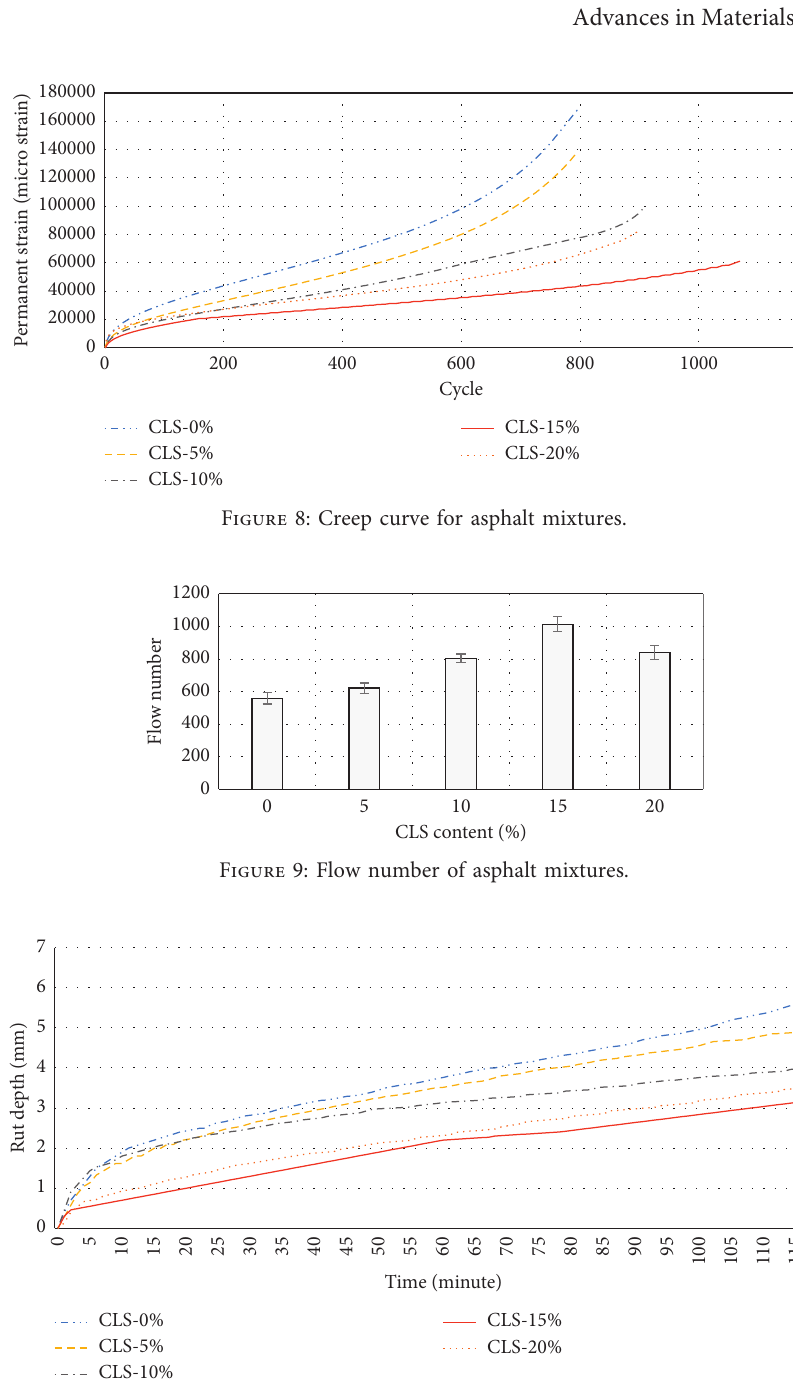
Figure 10: Measurements of the rut depth at 60 °